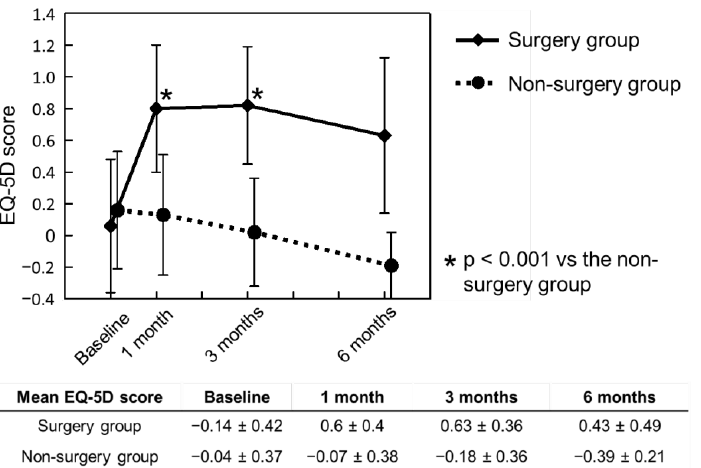
Figure 4. Chronological changes in the EQ-5D score preoperatively and at 1, 3 and 6 months after study commencement; EQ-5D: EuroQol Five-Dimension questionnaire. The prevalence of ambulatory patients was significantly higher in the surgery group than in the non-surgery group at 1 month ( p = 0.007) and 3 months ( p = 0.028) but not at 6 months ( p = 0.345) (Table 3). Table 3. Numbers of ambulatory patients in the surgery and non-surgery groups. n ( % ) Baseline